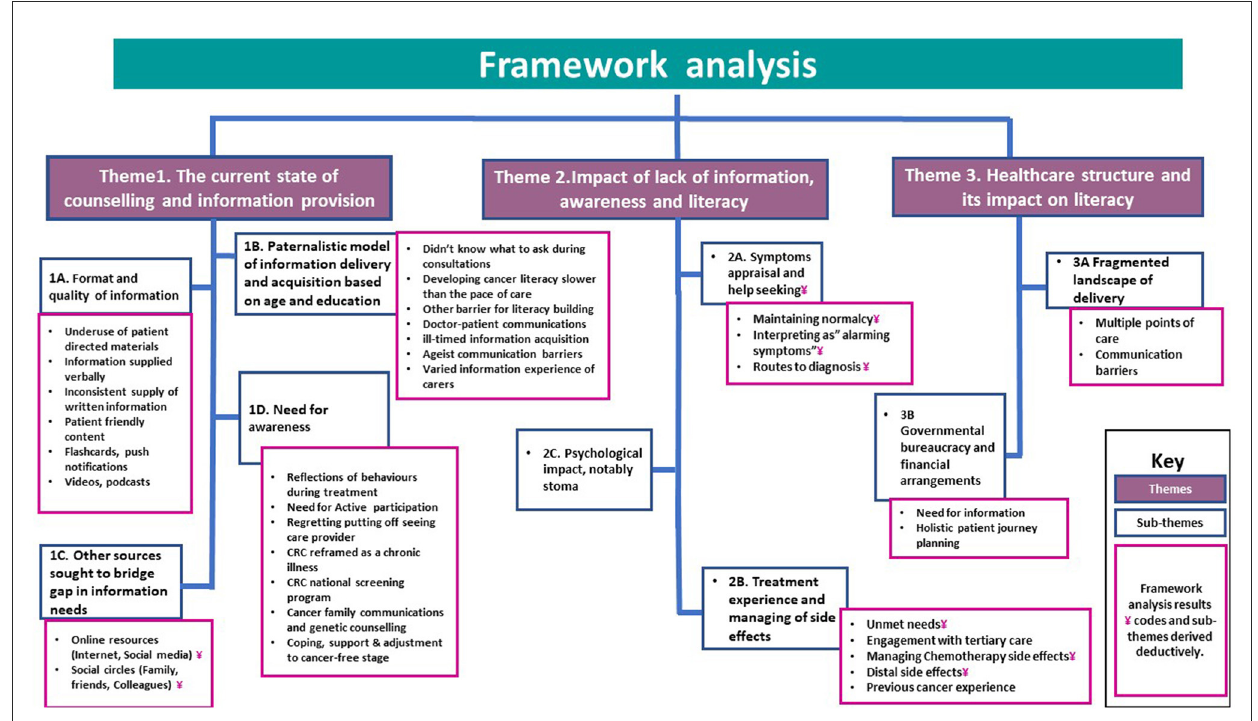
FIGURE2 Theme(s), subthemes, and framework analysis findings.